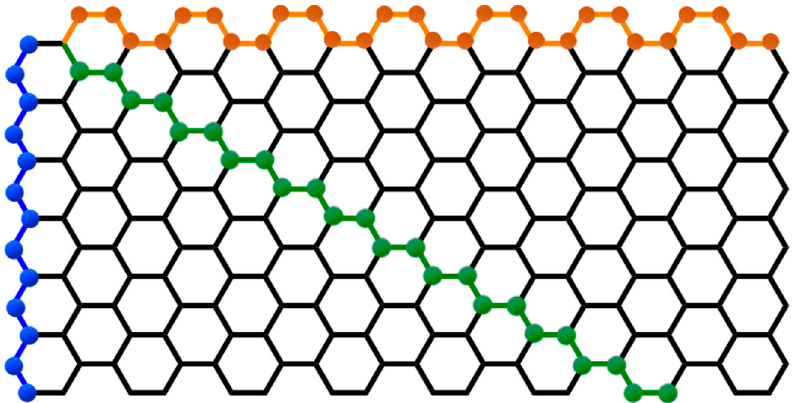
Figure 9. Classification of single-walled carbon nanotubes with distinct geometry and properties: Armchair ( orange ), zigzag ( blue ) and chiral ( green ).